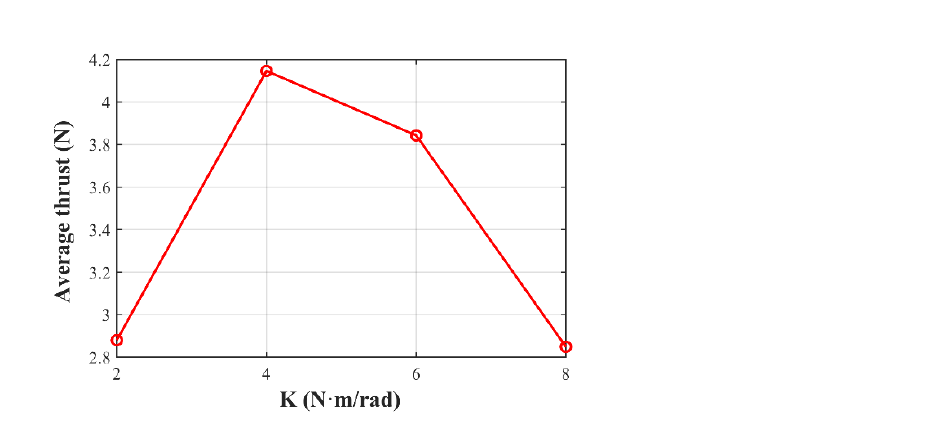
( d ) Figure 16. The forward thrusts of the SALL submerged glider under the different K and λ . ( a ) For- ward thrust under k = 2; ( b ) forward thrust under k = 4; ( c ) forward thrust under k = 6; and ( d ) forward thrust under k = 8.